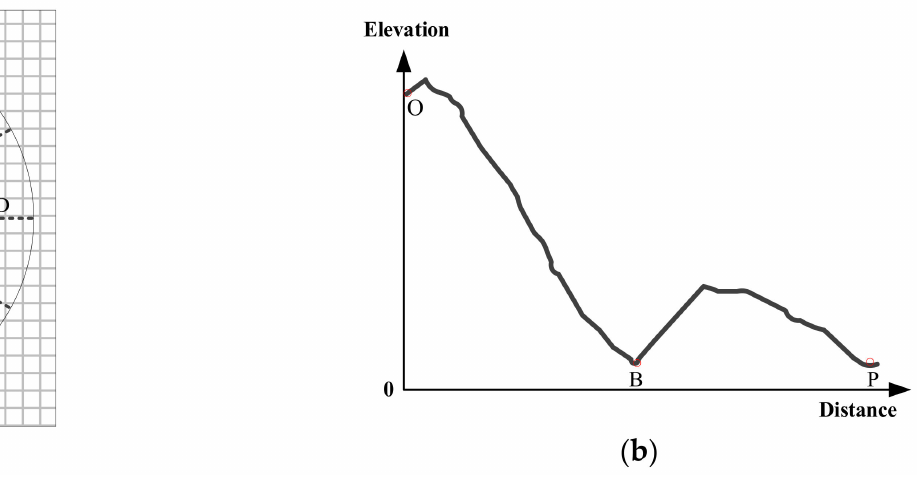
Figure 11. Determination of drainage scope. ( a ) Points A-L are the extracted PSs (marked as red points). Connecting the A–L in order is the scope of the RD (marked as a red segment). ( b ) A profile generated by the radius OP (marked as blue segment), which clearly reflects the location of the points on the